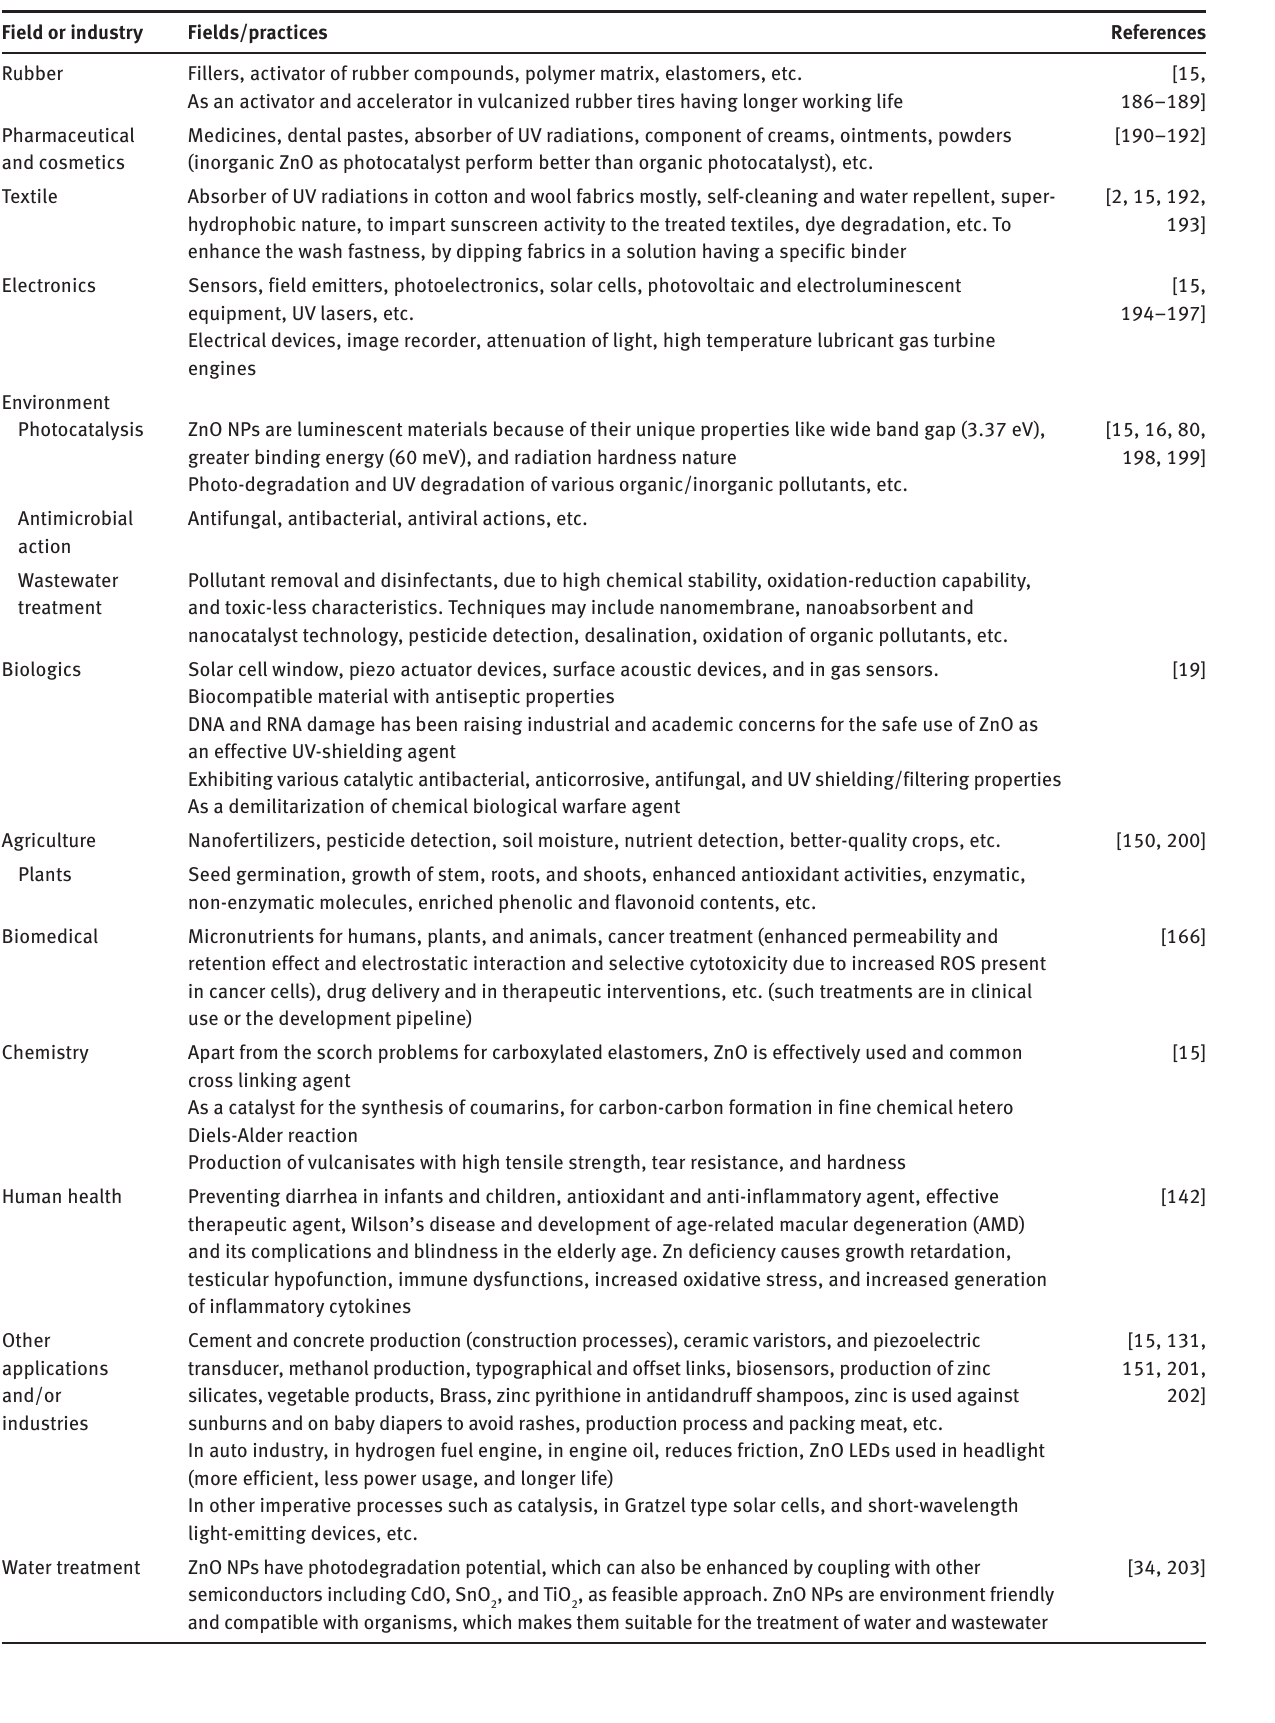
Table 7: Summarized applications of ZnO NPs in nearly all